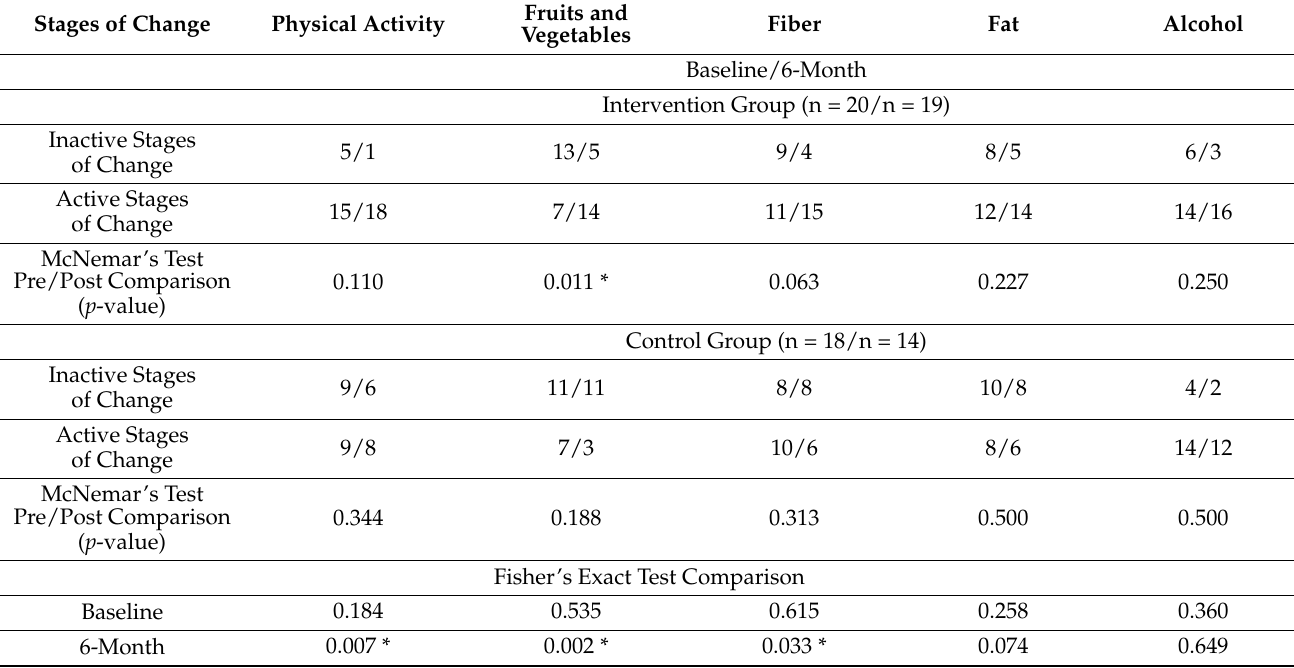
Table 3. Frequency of Grouped Stages of Change at Baseline and 6 Months and Comparison of Parameter Changes of People Living with HIV and Prediabetes in Intervention and Control Groups Participating in a Nutrition Intervention to Progress through Stages of Change.